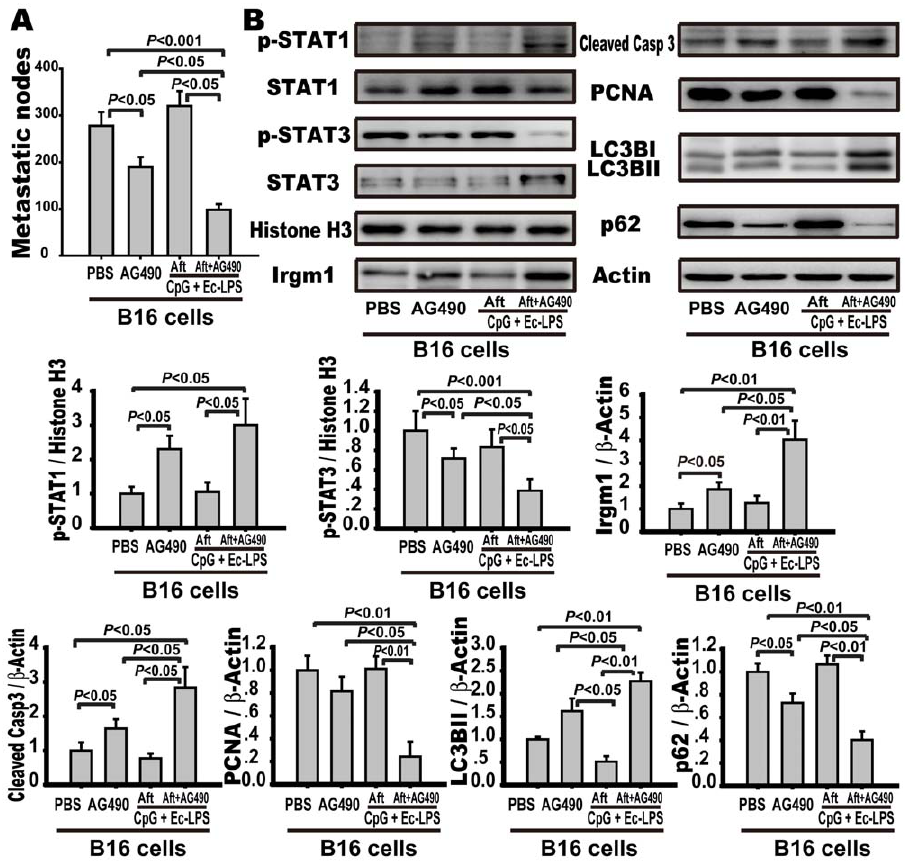
Figure 6. Therapeutic application of TLR4/TLR9 agonist complex and AG490 act synergistically to attenuate metastasis. C57BL/6 mice were injected with B16-F10 melanoma cells (5 6 10 5 ) and were humanely sacrificed 14 days after tumor cell inoculation. The mice were intraperitoneally injected with the TLR4/TLR9 agonist complex (dosage and frequency stated in the legend of Fig. 1) with or without AG490 (30 mg/ kg, once a day) after tumor cell inoculation. (A) Metastatic nodules were counted and summarized, and the data are the mean 6 S.E. (n=10). (B) The expression of STAT1/3 singling and autophagy-related molecules in the lung tissue. The lungs were excised and the cytoplasmic and nuclear fractions were extracted as described in the Methods. The expression of p-STAT1, STAT1, p-STAT3, STAT3, and histone H3 in nucleic extracts and IRGM1, LC3B, cleaved caspase-3, P62, PCNA, and b -actin in the cytoplasm were detected with Western blotting. Left panel is representative western blots and right panels are summary results. Data are presented as the mean 6 S.E. of 5 mice per